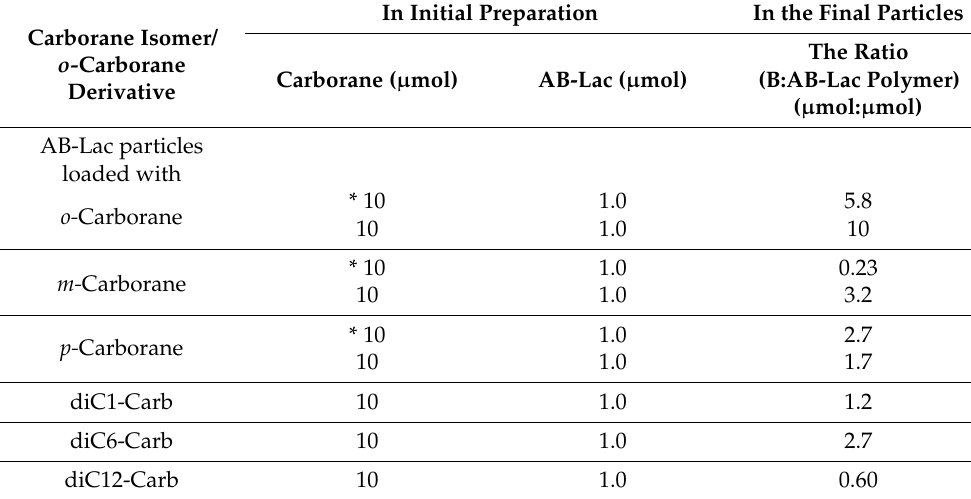
Table 1. The B compounds loaded in the AB-Lac particles. In Initial Preparation In the Final Particles Carborane Isomer/ o- Carborane Carborane ( µ mol) AB-Lac ( µ mol) Derivative